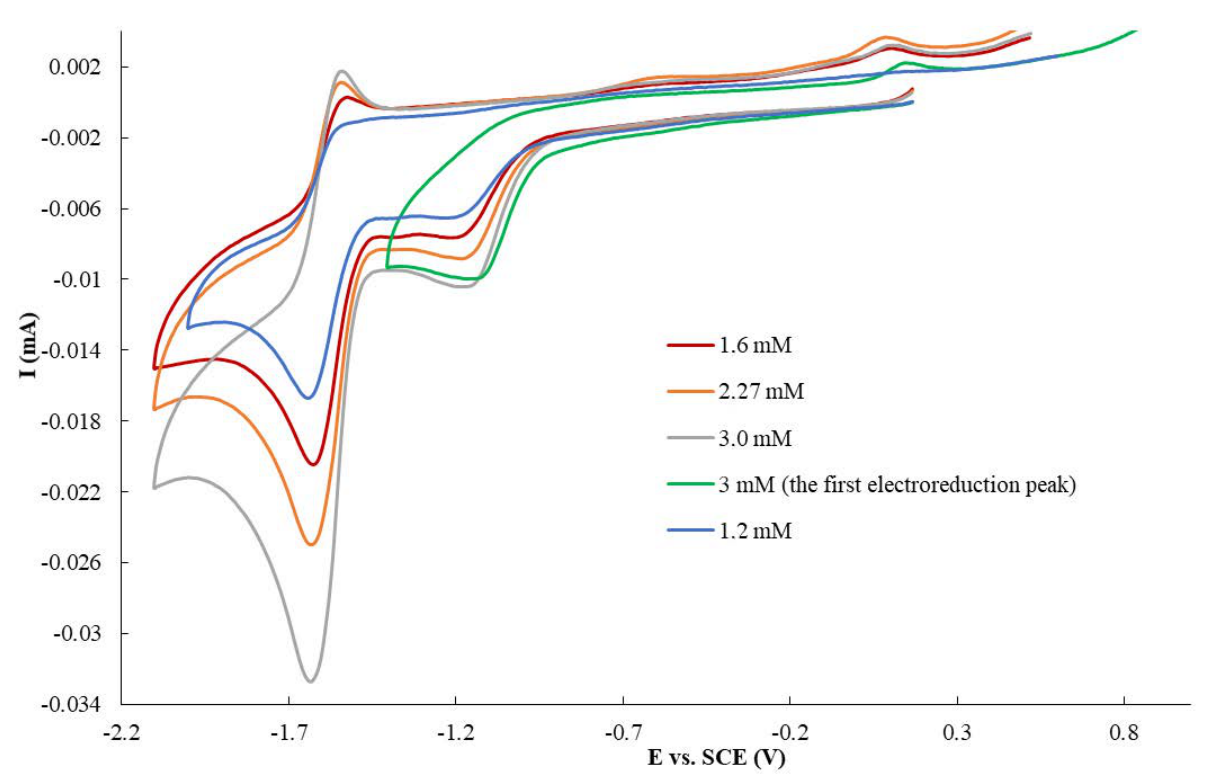
Figure 4. CVs obtained in the presence of compound 1a at various concentrations, 1.2, 1.6, 2.3, and 3.0 mM, in a DMF solution (0.1 M Bu 4 NClO 4 ). v = 100 mVs − 1